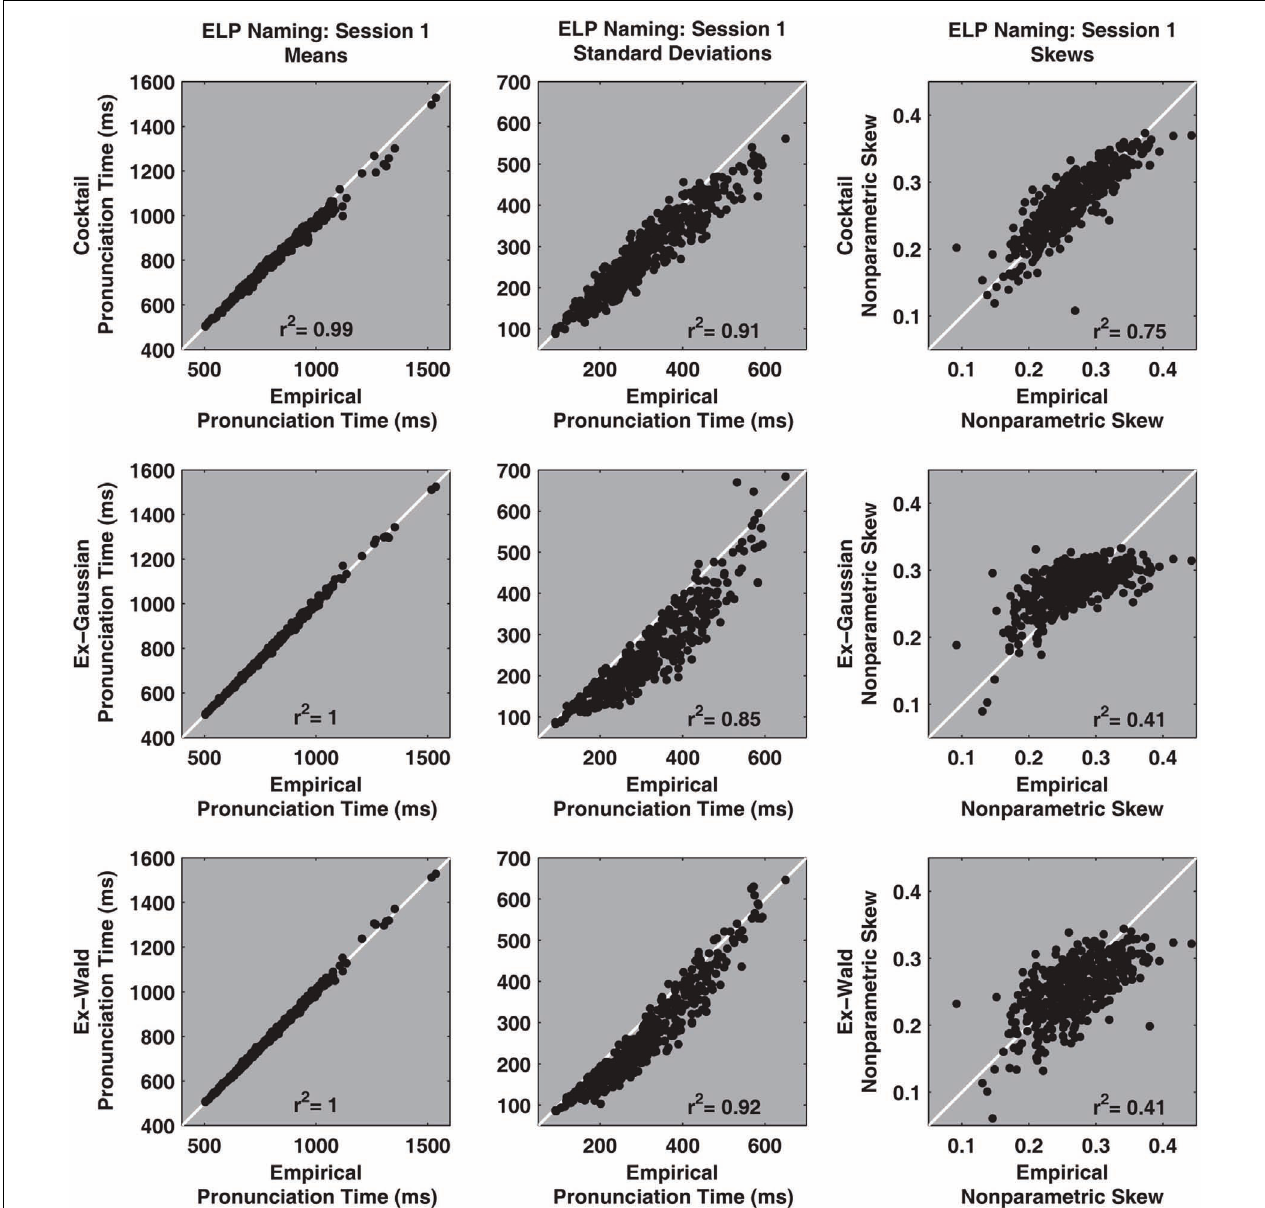
third rows depict the same contrasts for the ex-Gaussian and e-Wald distributions, respectively. Overall, the cocktail description recovers descriptive parameters better than the exponential alternatives.The estimates were computed for all participants, regardless of whether the fits were reliable or